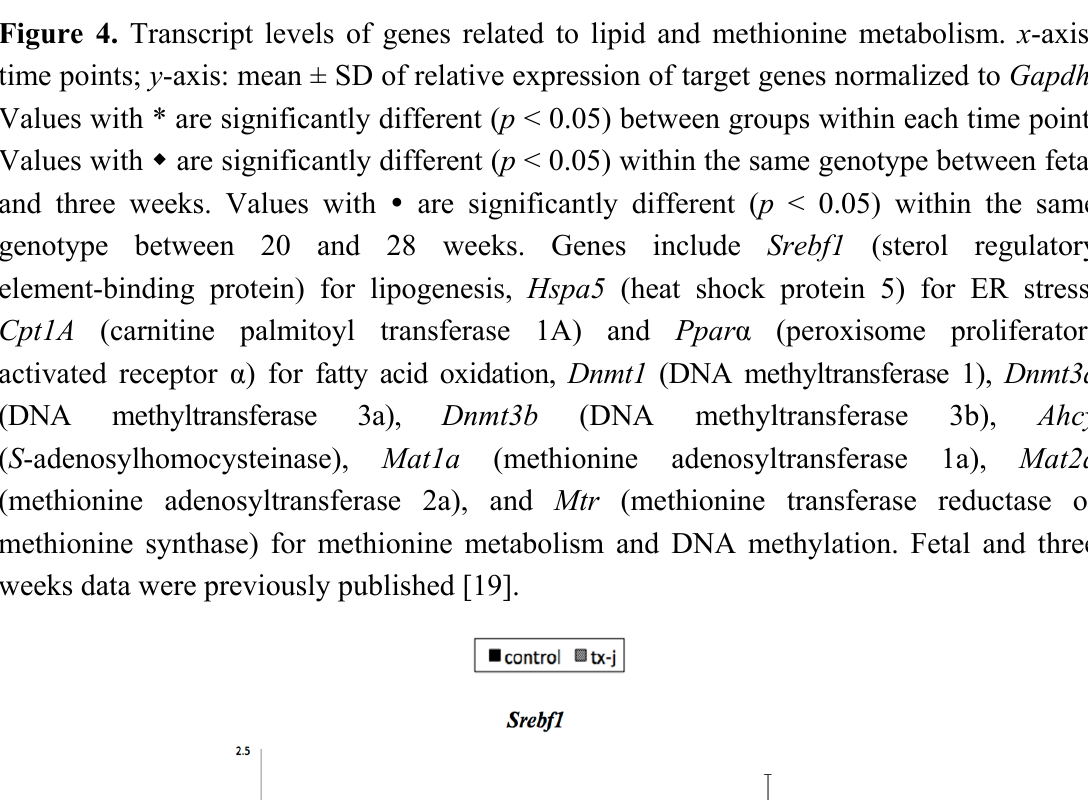
Figure 4. Transcript levels of genes related to lipid and methionine metabolism. x -axis: time points; y -axis: mean ± SD of relative expression of target genes normalized to Gapdh . Values with * are significantly different ( p < 0.05) between groups within each time